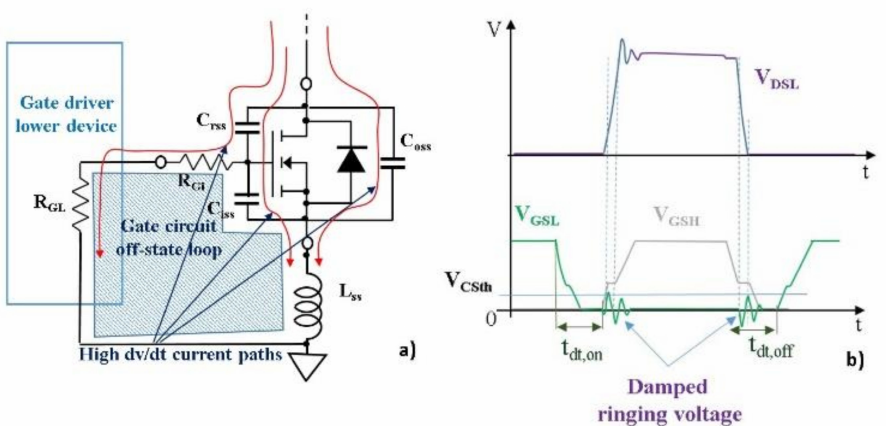
Figure 24. ( a ) Low-side GaN FET device in off-state current paths and parasitic passive components model. ( b ) Qualitative switching waveforms of the node voltage, low-side gate voltage V GSL and high-side gate voltage V GSH